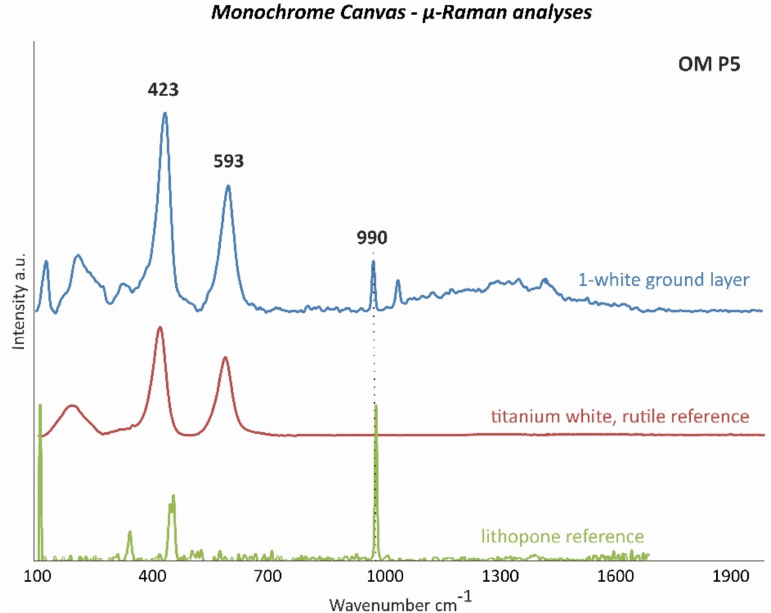
Figure 4. µ -Raman spectra of the white ground layer 1 of OM P5 (blue line) and of the titanium white, rutile (TiO 2 ) (red line), and lithopone (BaSO 4 + ZnO) (green line) references as the main detected